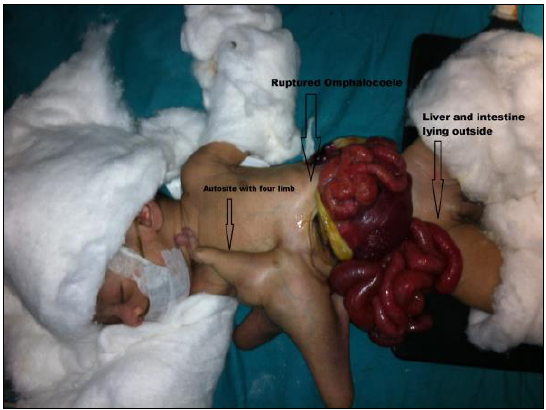
Figure 1: Preoperative